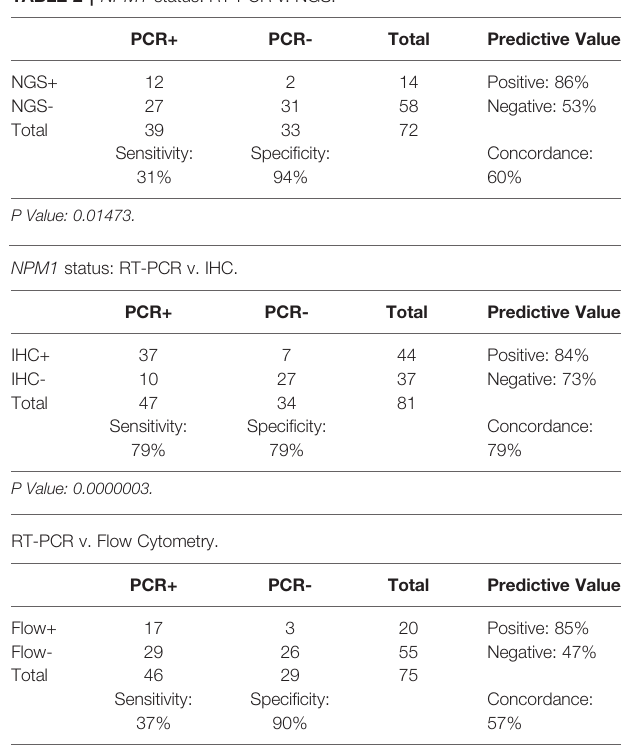
TABLE 2 | NPM1 status: RT-PCR v.